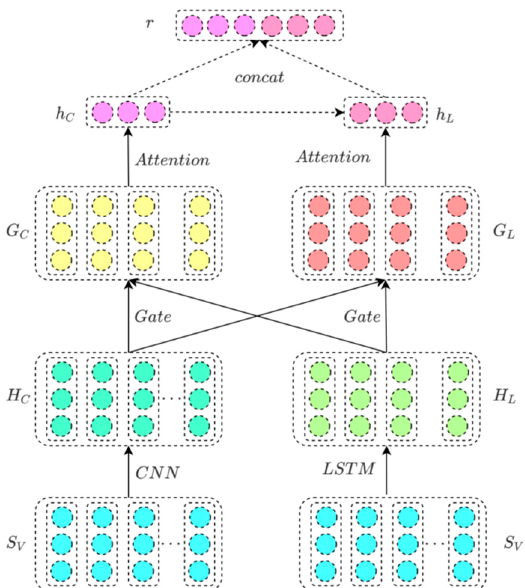
Figure 1. Overall model structure.